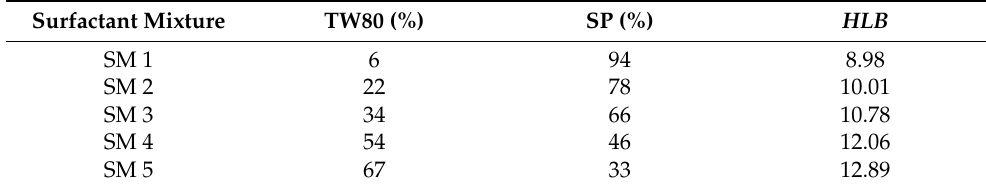
Table 6. Concentrations of the Tween 80 (TW80) and Span 20 (SP20) surfactant mixtures and their corresponding